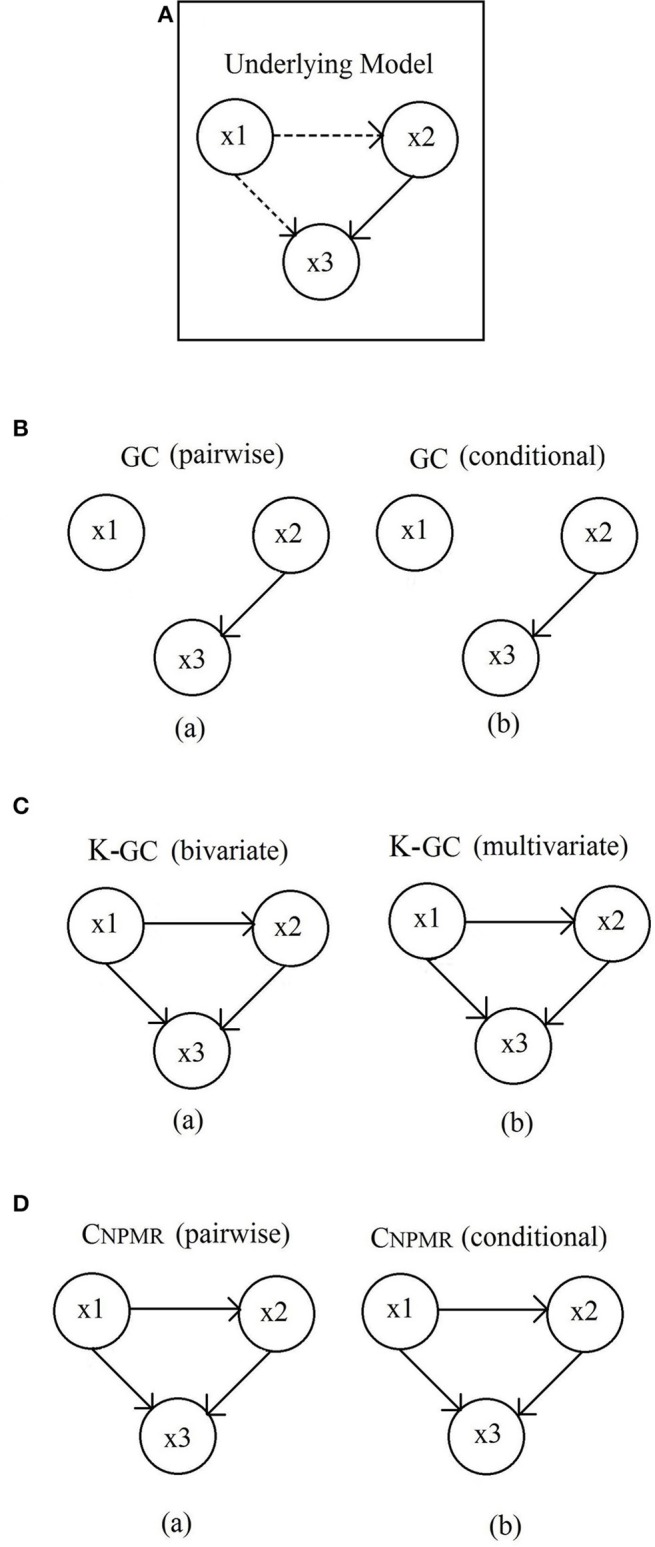
Dataset 3. (A) Underlying model. Solid line: linear connection; Dashed line: non-linear connection. (B) Linear Granger causality. (a) pairwise GC; and (b) conditional GC. Unsurprisingly, only the linear connection x2 → x3 is identified. (C) Kernel-Granger causality. (a) bivariate K-GC; and (b) multivariate K-GC. (D) Significant CNPMR models obtained from (a) pairwise and (b) and conditional method. Both pairwise and conditional CNPMR estimators identify all linear and nonlinear connections correctly.